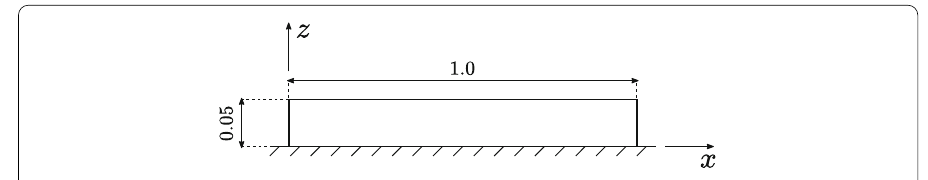
Fig. 9 Geometry and boundary conditions of two-dimensional domain: bottom edge fixed; left, right and top edge free. Dimensions in mm (not to scale)